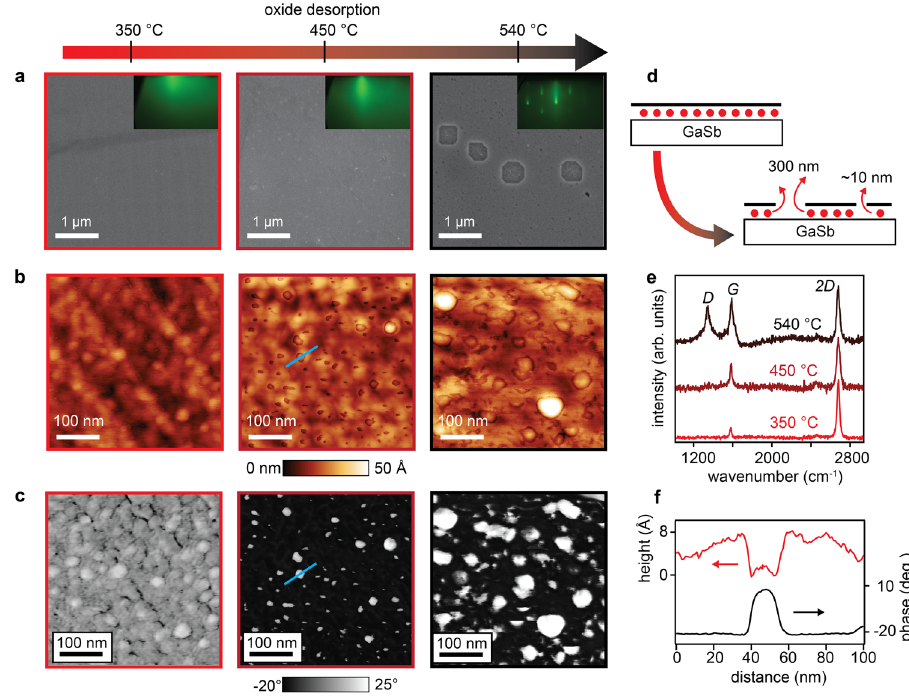
Fig. 3 Pinholes created by native oxide desorption. a SEM images and RHEED patterns tracking the native oxide desorption and creation of large 300 nm diameter holes. b AFM height images. Pinholes with diameter ~10 nm appear at the onset of native oxide desorption, 450 °C. c AFM phase contrast images. The phase contrast arises from differences in elastic modulus between the graphene and the holes with exposed GaSb. d Schematic of the oxide desorption process leading to the creation of holes with different sizes. Red circles represent oxides. e Raman spectra at various stages during oxide desorption. Strong D peak activation coincides with the appearance of large holes after annealing at 540 °C. f AFM height and phase line pro fi les extracted from the 450 °C sample. The corresponding line cut is marked by the blue line in the AFM images.